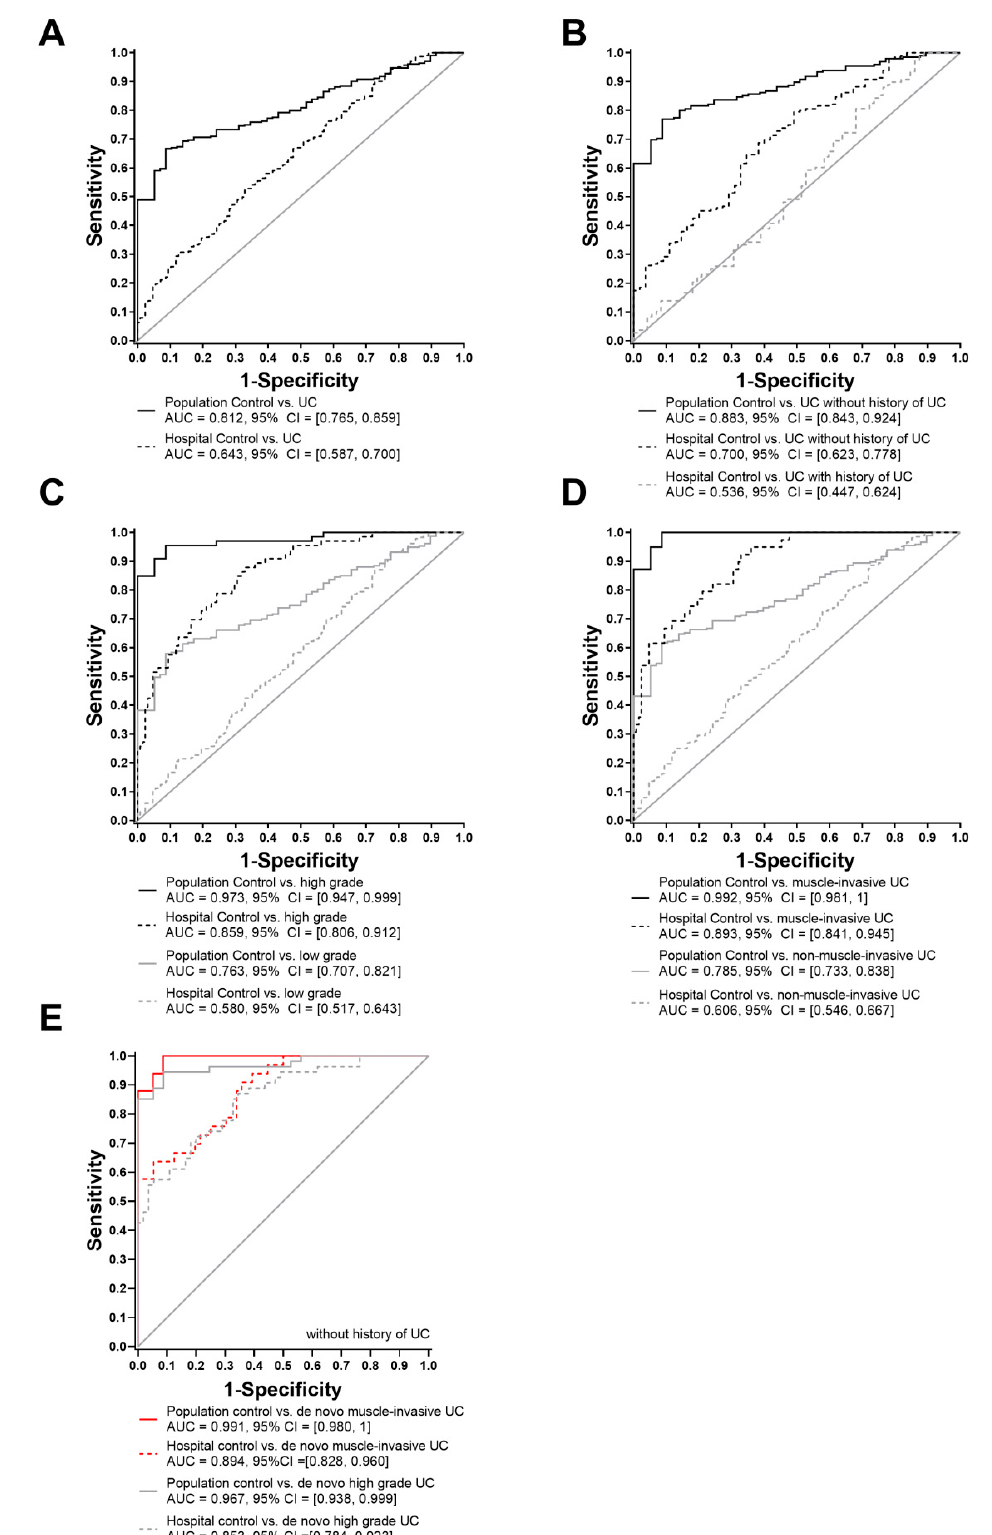
Figure 4. ROC curves of urinary TGFBI concentrations. The areas under the curves (AUCs) were determined by comparing different control groups to patients with ( A ) urothelial carcinoma, ( B ) de novo and recurrent UC, ( C ) low and high-grade UC, ( D ) non-muscle invasive UC ( ≤ pT1) and muscle invasive ( > pT1) UC ( E ) and de novo muscle invasive or high-grade UC.